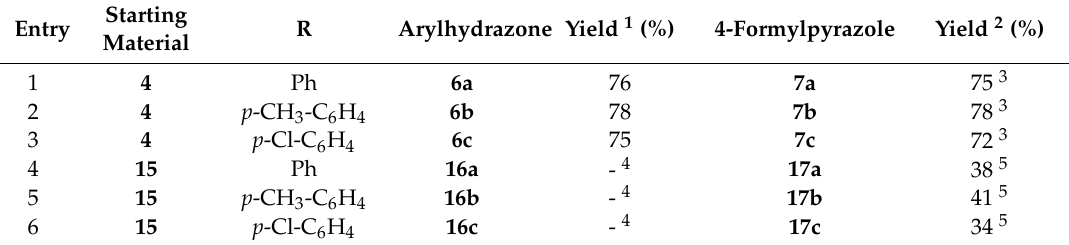
Table 1. Synthesis of arylhydrazones from steroidal and non-steroidal methyl ketones and their conversion to